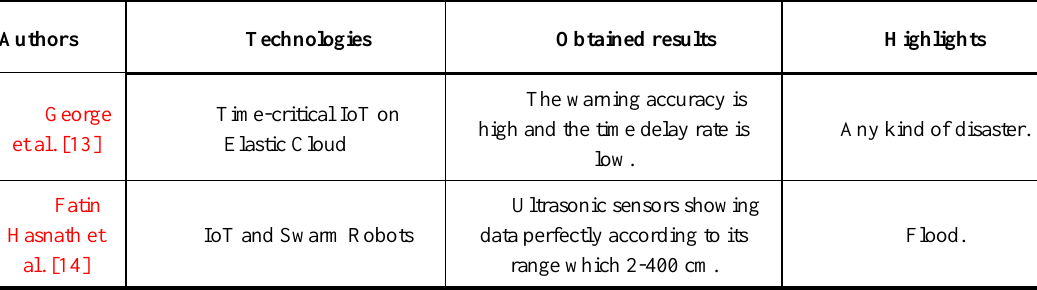
Table 2. Different techniques, test results and application directions for early